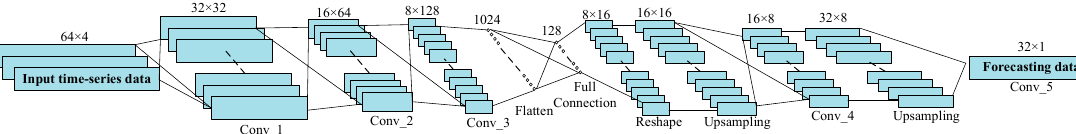
8 of 18 Figure 3. Constitution of input and output matrices. 3.3. Forecasting Model Structure